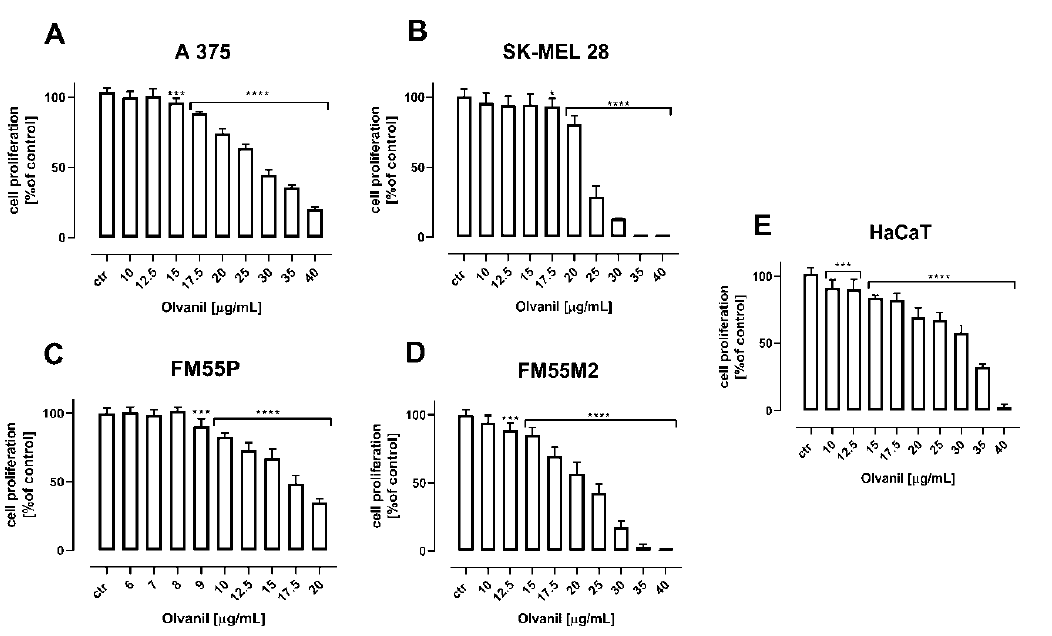
Figure 7. The effect of olvanil on the proliferation of malignant melanoma cell lines [A375 ( A ), SK–MEL 28 ( B ), FM55P ( C ), FM55M2 ( D )], and normal human keratinocytes [HaCaT] ( E ) measured by means of BrdU assay after 72 h. Results are presented as mean ± SEM (* p < 0.05, *** p < 0.001, **** p < 0.0001).